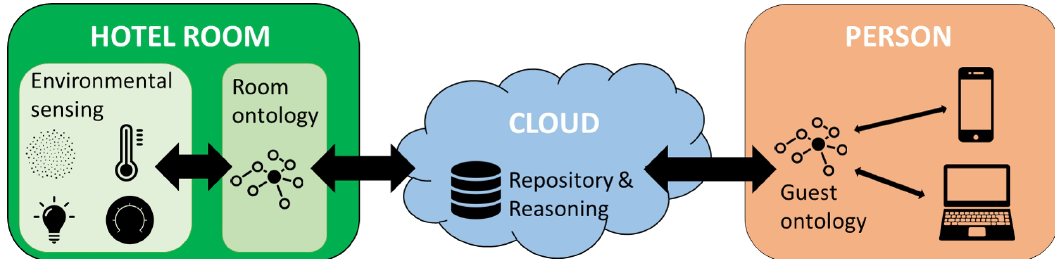
Figure 2. A schema describing RoomFort’s